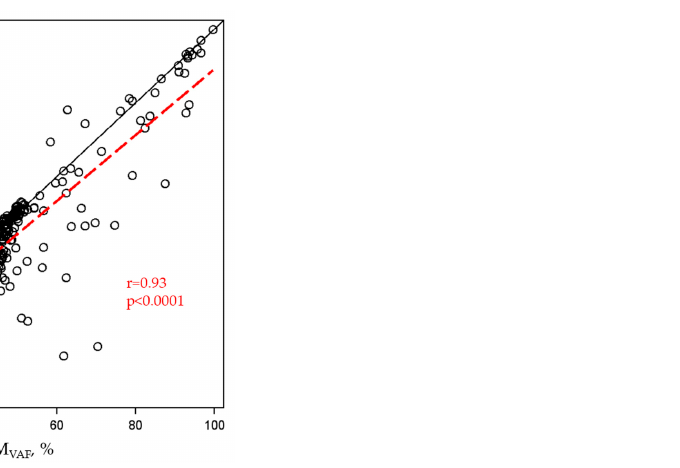
Figure 3. Scatterplot of the variant allele frequency (VAF) of the mutated genes in bone marrow and peripheral blood. The black line is the bisecting line showing a perfect linear regression with slope = 1 and intercept = 0. The red dashed line is the regression line, indicating the correlation between BM VAF and PB VAF of each paired sample. To determine whether the correlation might be di ff erent for patients with a poten- tially reduced tumor load in the peripheral blood, i.e., in patients with 0% peripheral blood blasts or with <1.0 G/L absolute neutrophil count, we performed the respective anal- yses for these patient subgroups (Figure 4). The correlation remained very strong for pa- tients in all subgroups, i.e., in patient samples with either peripheral blood blasts = 0% (n = 165; r = 0.92, p < 0.0001) or ≥ 1% (n = 74, r = 0.95, p < 0.0001), and with an absolute neutro- phil count of <1.0 G /L (n = 66; r = 0.88, p < 0.0001) or ≥ 1.0 G /L (n = 174; r = 0.95, p < 0.0001). To determine whether the bone marrow blast percentage might correlate with the BM VAF and/or whether the peripheral blood blast percentage correlated with the PB VAF , we plo tt ed these values against each other in Figure 5A,B. The Spearman correlation coe ffi - cients were low, with r = 0.11 ( p < 0.004) in the bone marrow (Figure 5A) and r = 0.19 ( p < 0.0001) in the peripheral blood (Figure 5B), indicating a weak correlation between blast counts and the detected VAFs.